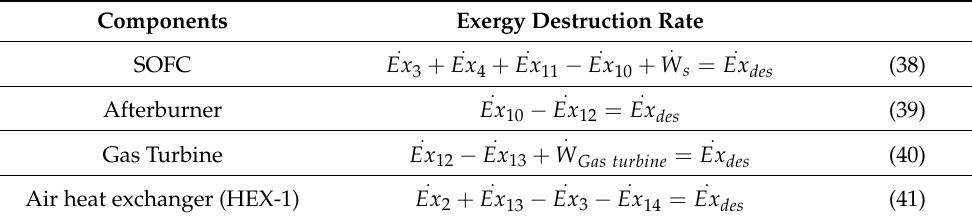
Table 2. Exergy destruction equations of the main components.